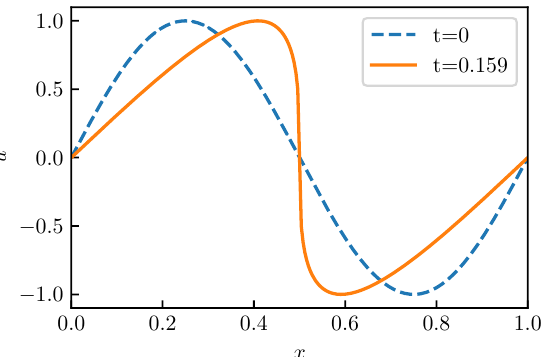
Figure A1. The distribution of u at t = 0 and t = 0.159 for the initial value problem of the 1-D Burgers